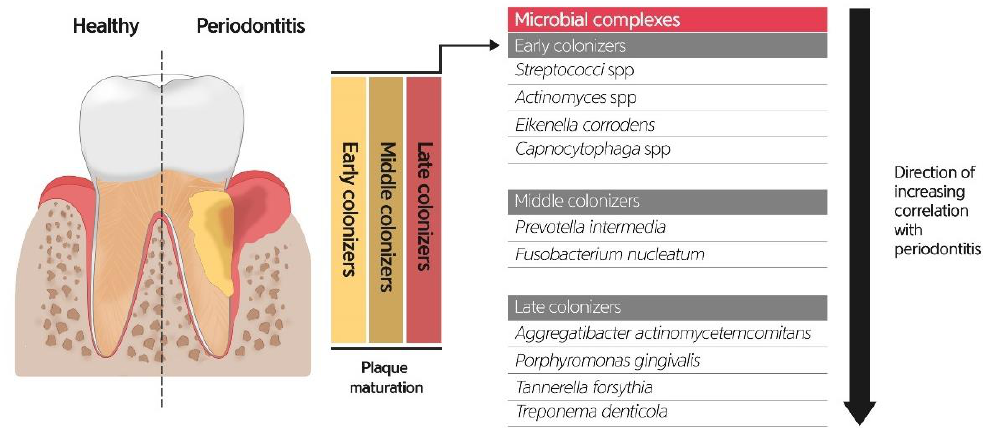
Figure 4. Bacterial colonizers related to periodontitis (adapted from [69,72,73])